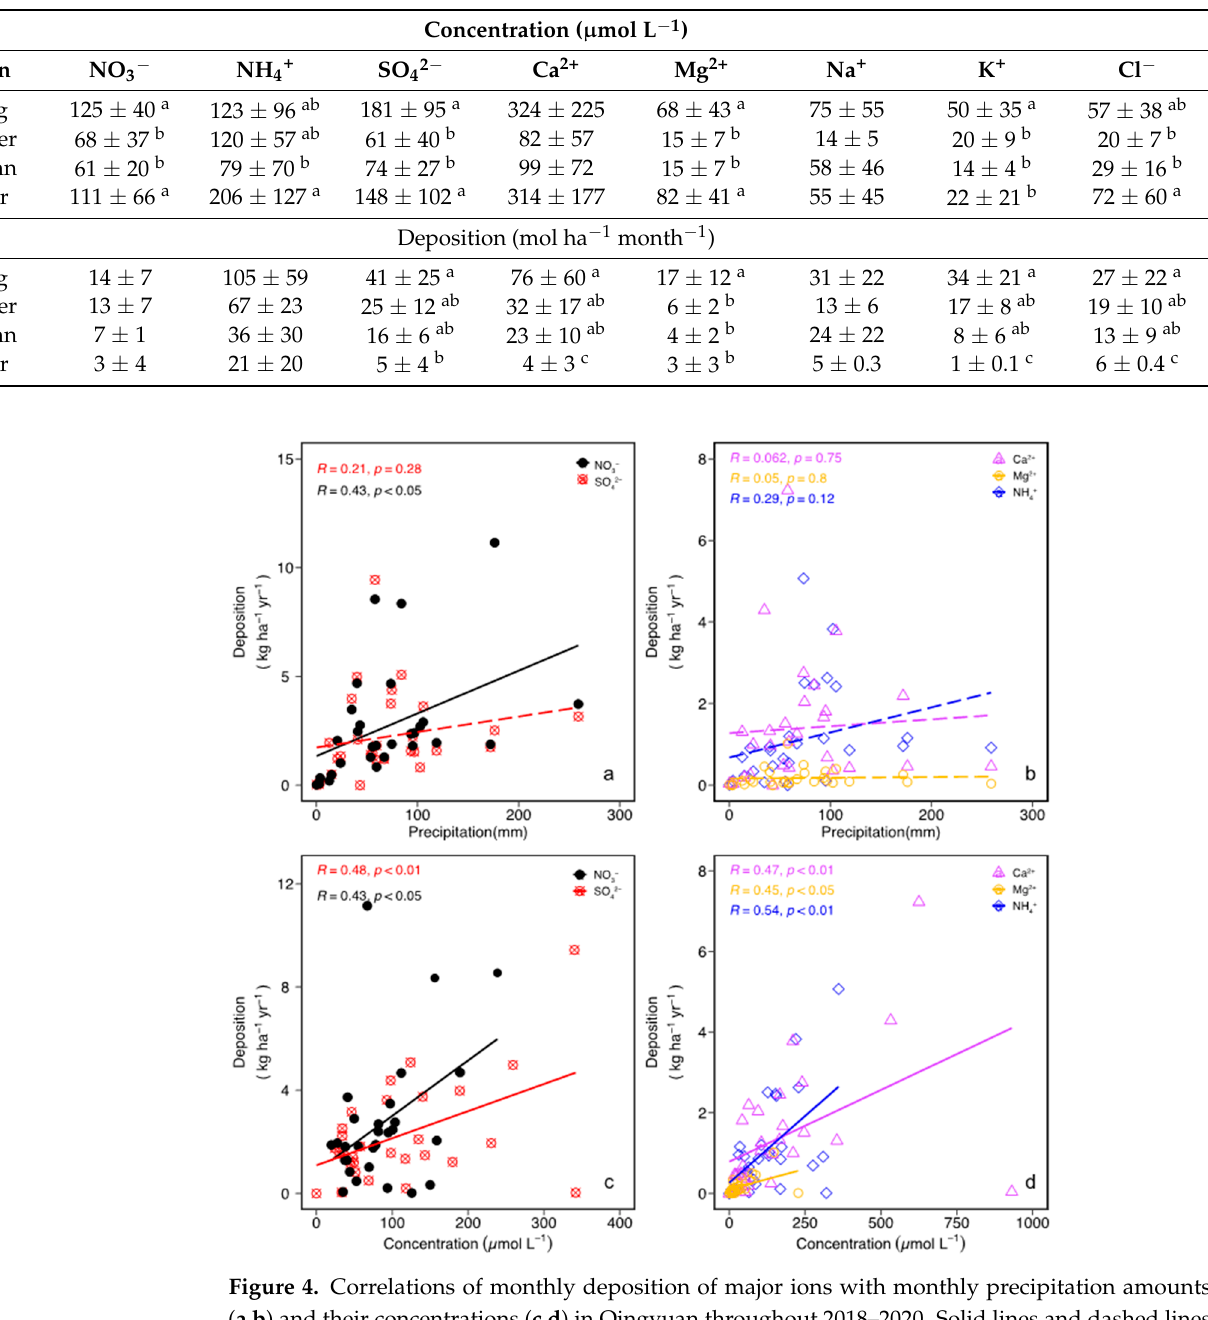
Table 2. Seasonal mean concentrations and deposition of major ions in precipitation at the study site. Numerical means ± SD were given. Superscript letters indicate significant differences among seasons ( p < 0.05, one-way ANOVA, Duncan test).